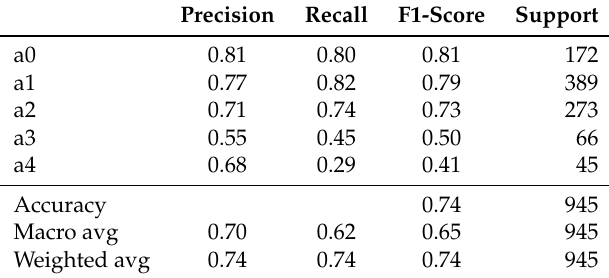
Table 8. kNN model alteration prediction score.